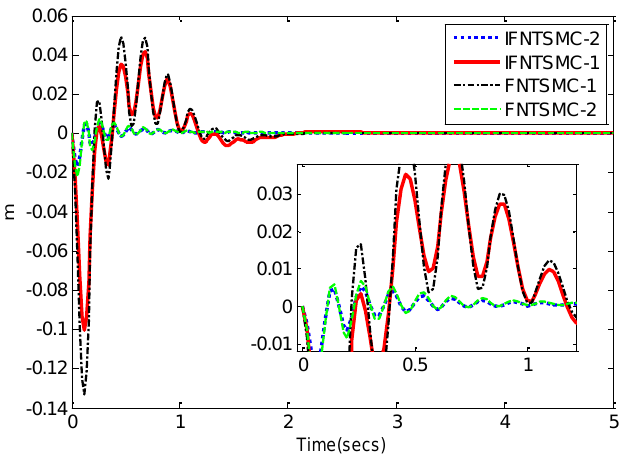
Figure 5. End vibration.